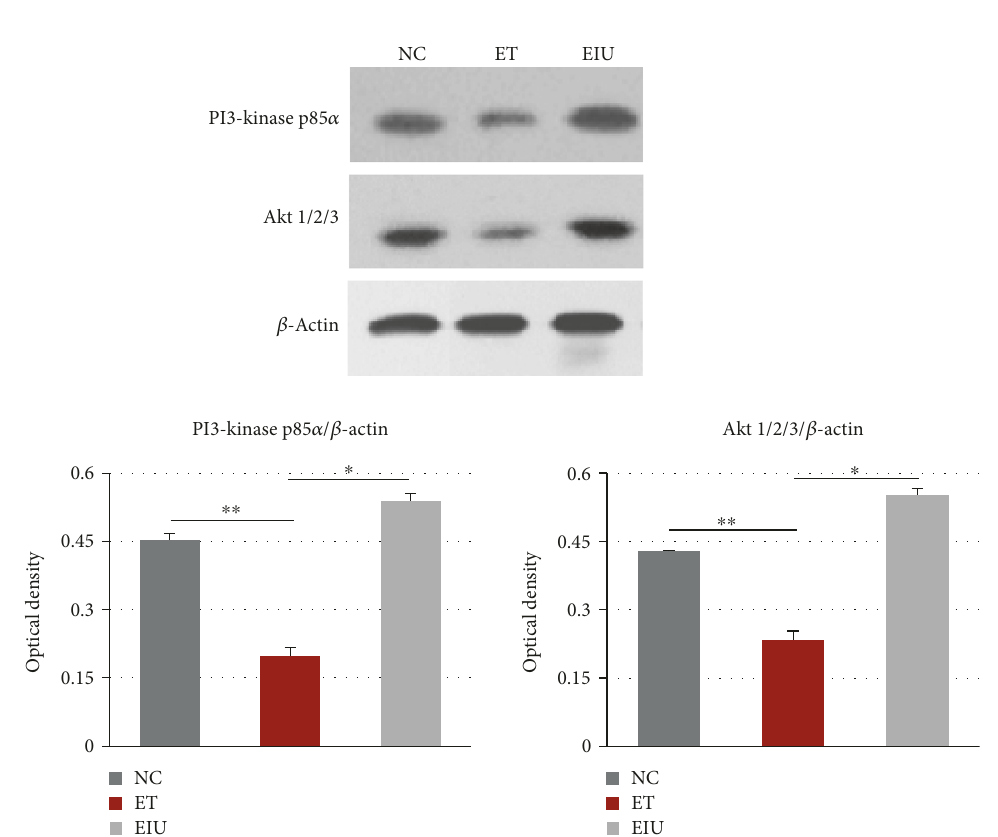
Figure 4: Western blot analysis and protein levels of PI3K and AKT. ∗ p < 0 05 the ET group versus the EIU group; ∗∗ p < 0 05 the ET group versus the NC group. Data represent the mean ± SD from ten independent experiments.